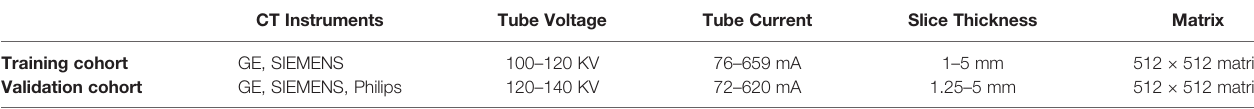
TABLE 1 | Summary of parameters of CT models and scanning